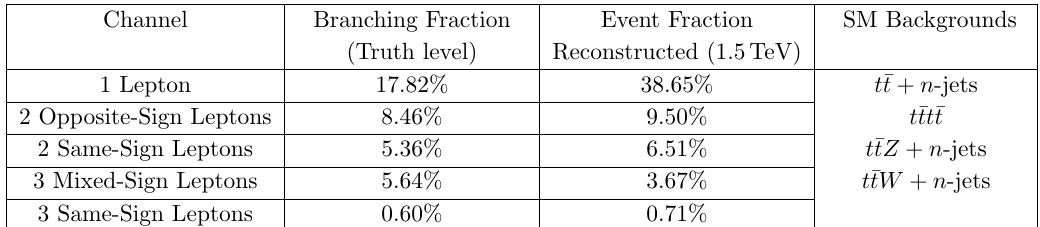
Table 1 . Analysis channels arising from six-top (cid:12)nal states with corresponding branch fraction, organized according to the number of leptons in the (cid:12)nal state. The events fraction including possible mixing between di(cid:11)erent channels when considering mis-identi(cid:12)cation and detector e(cid:11)ects for m t 0 = 1500 GeV are listed in the third column. Note that the around 1% lepton fake rate from the jets which results in more leptons due to the large multiplicity of the jets in each events. Dominant SM backgrounds are also listed in the last column.